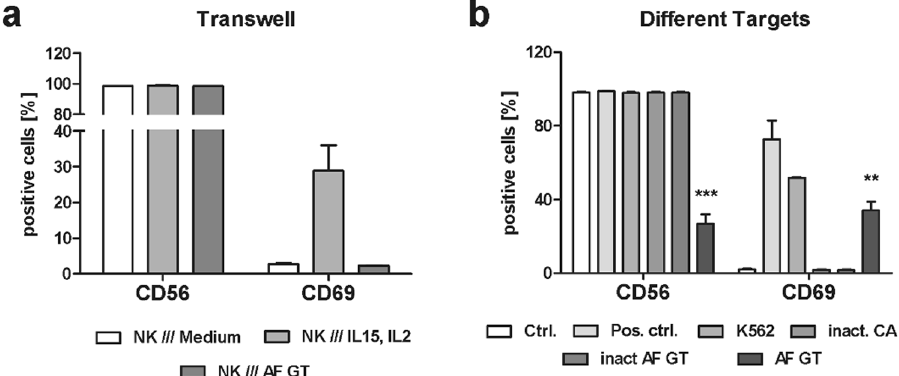
Figure 3. Reduction of CD56 is a result of the direct fungal contact. ( a ) NK cells were separated from fungal germ tubes (AF GT, MOI 0.5), medium supplemented with 500 U/ml IL-15 and IL-2 (Pos. ctrl) or medium (Ctrl.) by a transwell membrane (n = 3). ( b ) NK cells were cultured alone (Ctrl.), with 500 U/ml IL-15 and IL-2 (Pos. ctrl.), with K562 at an effector to target ratio of 5:1 (K562), with inactivated C . albicans (inact. CA, MOI 0.5) and with live and inactivated A . fumigatus germ tubes (AF GT, inact. AF GT, MOI 0.5, n = 6). Data are represented as mean ± SEM. Significant differences are marked with an asterisk ( ** p < 0.01, *** p < 0.005).